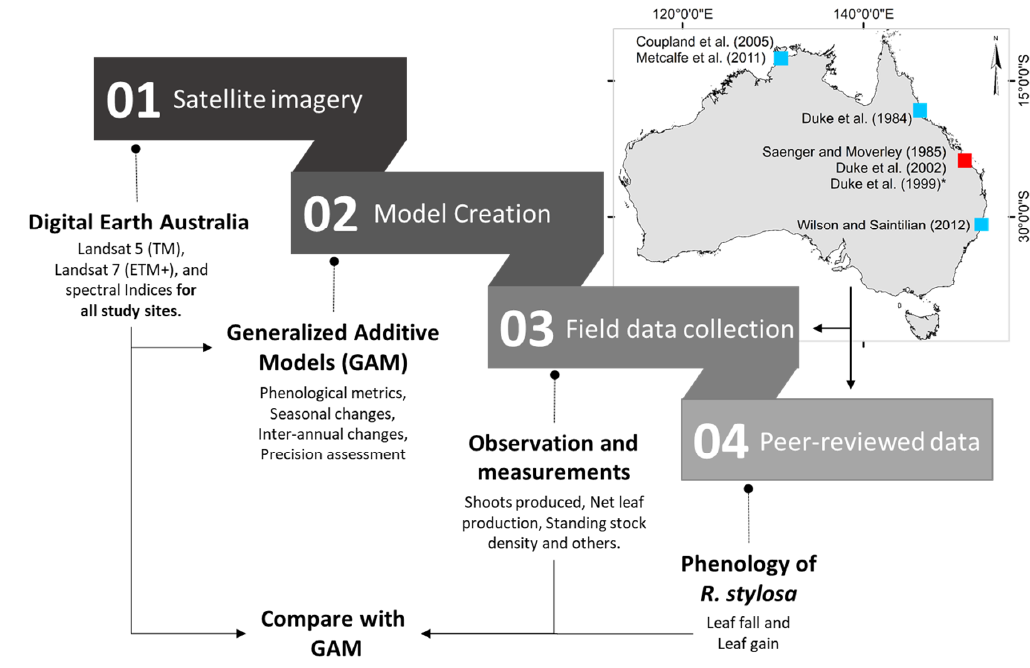
Figure 1. Workflow and location of the study sites used to validate the phenology model. * shows the location of the field site [26] and two other published studies used.